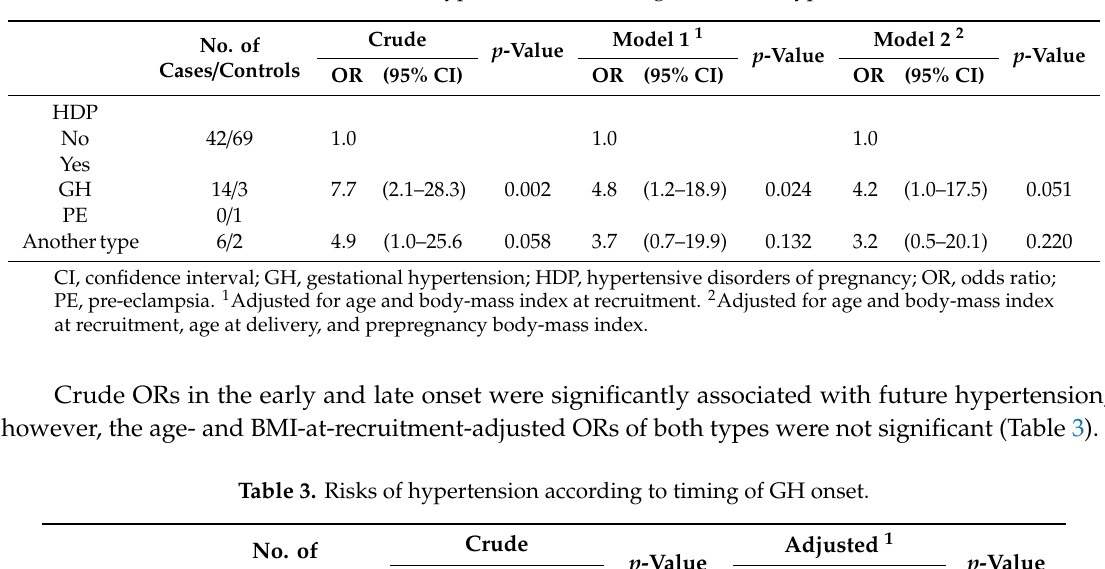
Table 2. Risks of hypertension according to HDP subtypes.